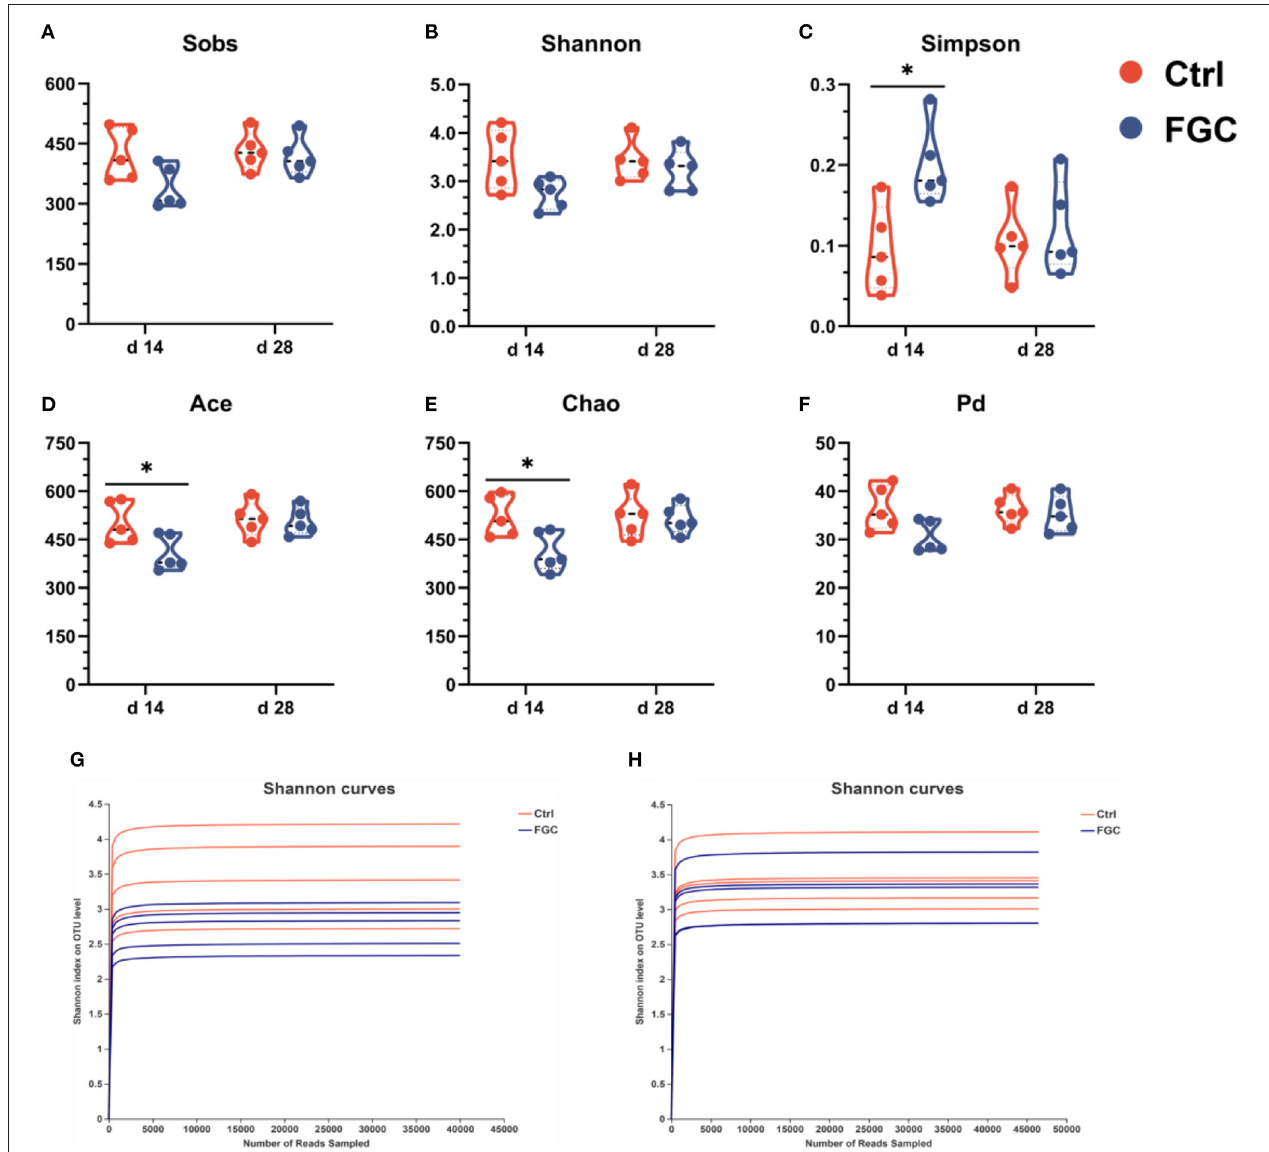
FIGURE 4 | Fecal microbial α -diversity and rarefaction curves at OTU level. (A) Sobs index. (B) Shannon index. (C) Simpson index. (D) Ace index. (E) Chao index. (F) phylogenetic diversity index. (G) Shannon curves at d 14. (H) Shannon curves at d 28. Ctrl, corn-soybean basal diet; FGC, corn-soybean basal diet with 2,000 mg/kg ferrous glycine chelate. Data were shown as means ± SEM. * p < 0.05. N =